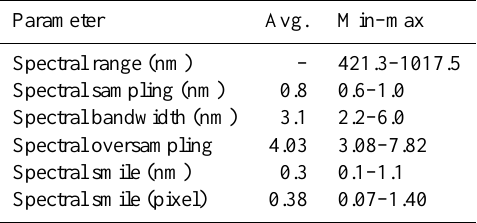
Table 6. Summary of the spectral properties of the specMACS VNIR sensor excluding the first 36 channels.